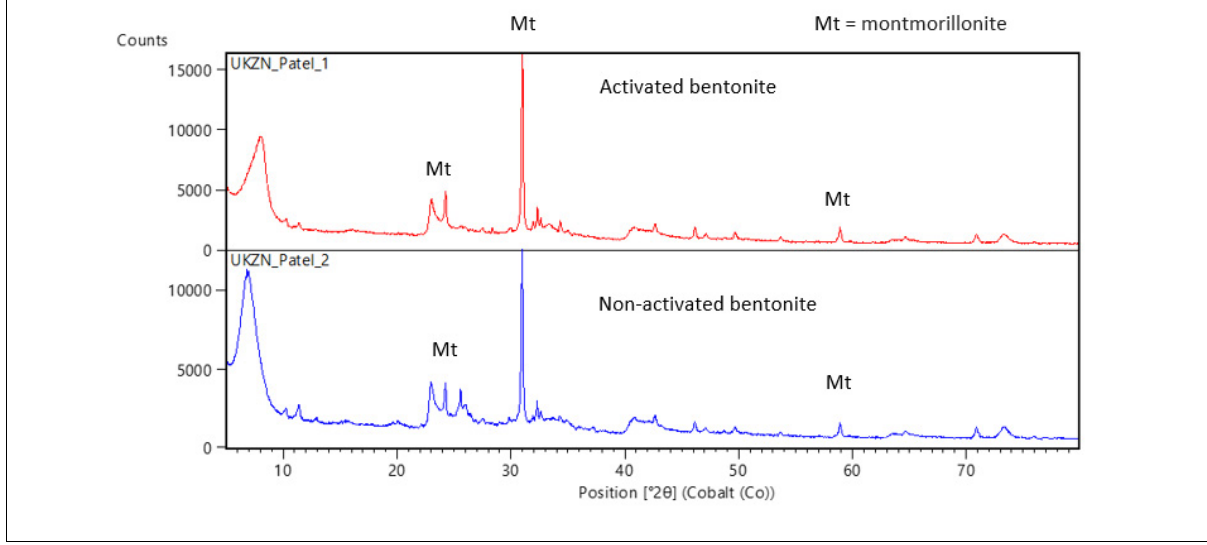
Figure 2: X-ray diffraction pattern of activated bentonite and non-activated bentonite.